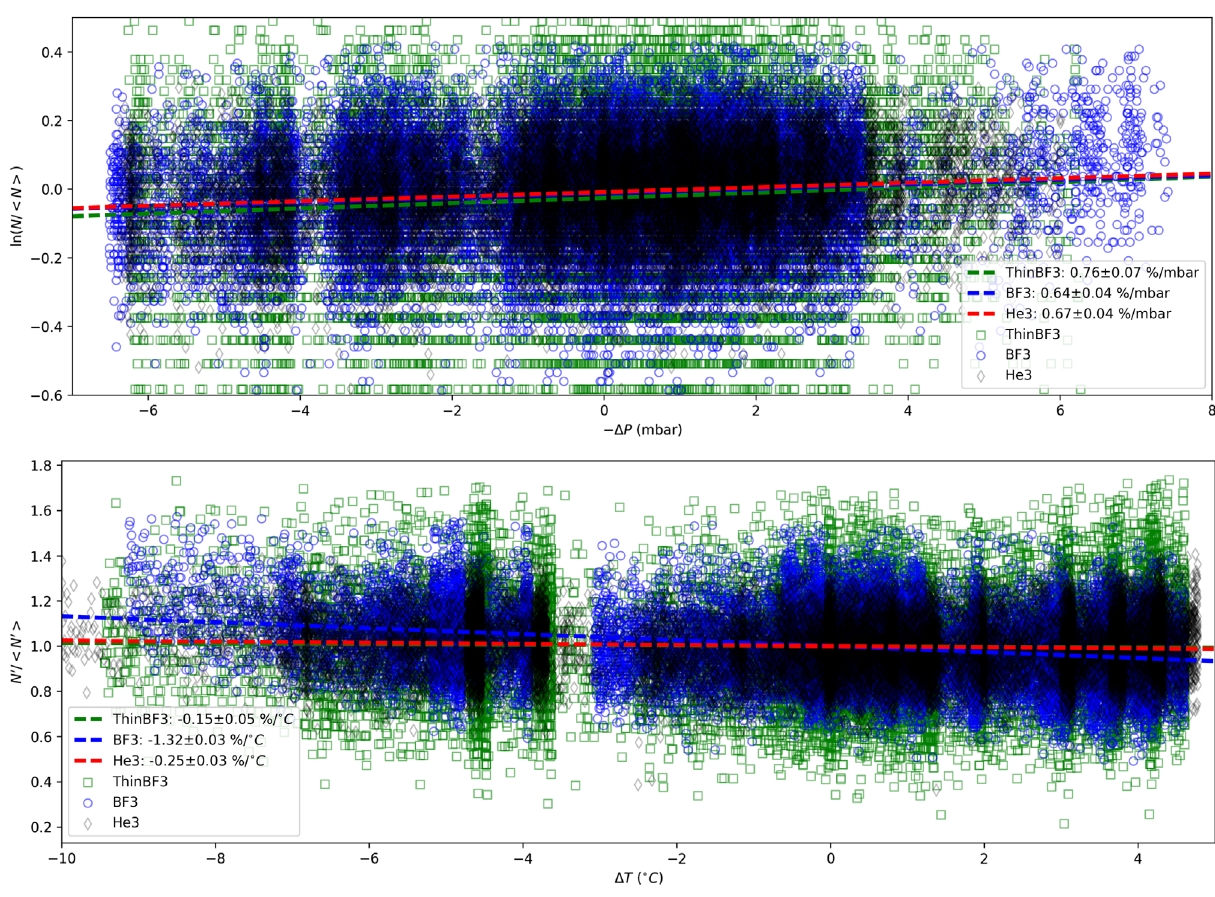
Fig. 7. The top panel shows the calculation of the barometric coef fi cient (the values indicated in the legend) for the different tubes (the thin BF 3 indicated by green symbols and lines, the BF 3 tube by blue, and the results for the 3 He tube by red). The bottom panel is similar, but now shows a test for any temperature dependence.